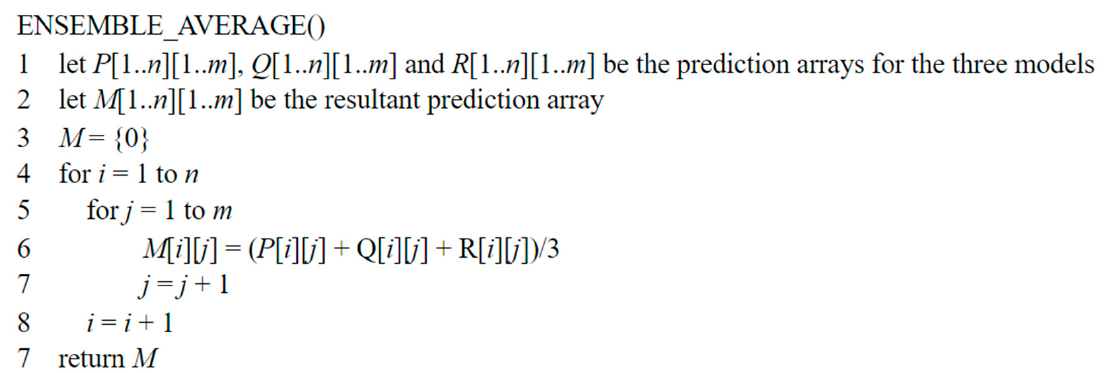
Figure 23. Algorithm for Model Averaging.